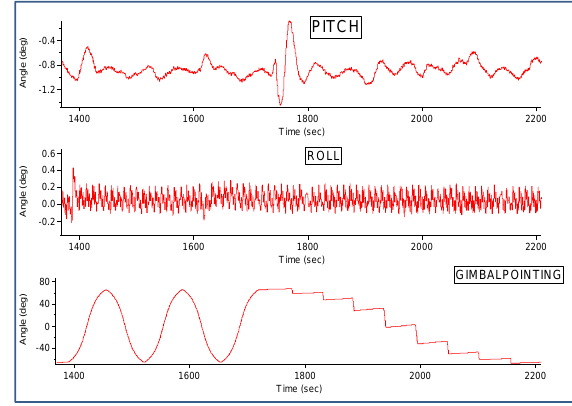
Figure 1.ER-2 Attitude Pitch and Roll angle linked to the AirMSPI gimbal pointing. The first time sequence between